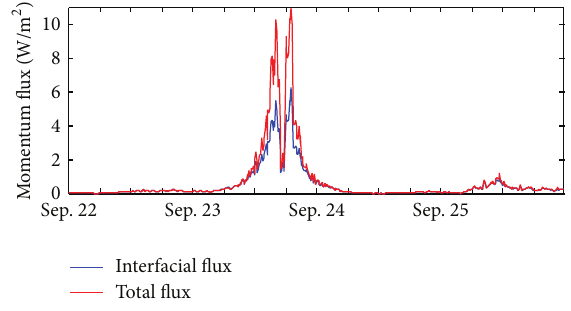
Figure 3: Time series of momentum flux at the KEO station where the simulated typhoon passed by at 18:00 September 23. Blue line and red line represent interfacial flux (without sea spray effect) and total flux (with sea spray effect),